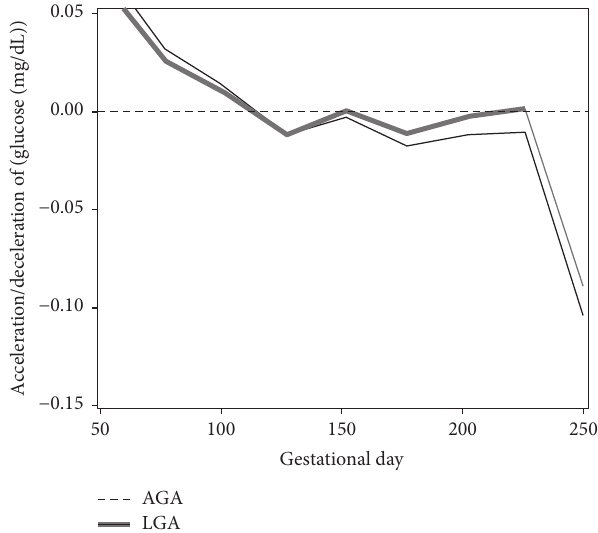
Figure 4: Patterns of acceleration and deceleration in glucose according to LGA (solid line) and AGA (dashed line) birth out- comes. Rates of change in glucose for each group were calcu- lated based on the second derivative ( 𝑦 -axis, mg/dL/day 2 ) against gestation time ( 𝑥 -axis, in days). Portions of each curve that are above zero imply acceleration, while portions of each curve that are below zero mark deceleration. The overlapping regions in the 95% pointwise confidence intervals indicate periods in which glycemic levels for both groups had similar acceleration or deceleration. (It should be noted that women delivering LGA infants had increased acceleration early in pregnancy and increased deceleration later in pregnancy compared with women delivering AGA